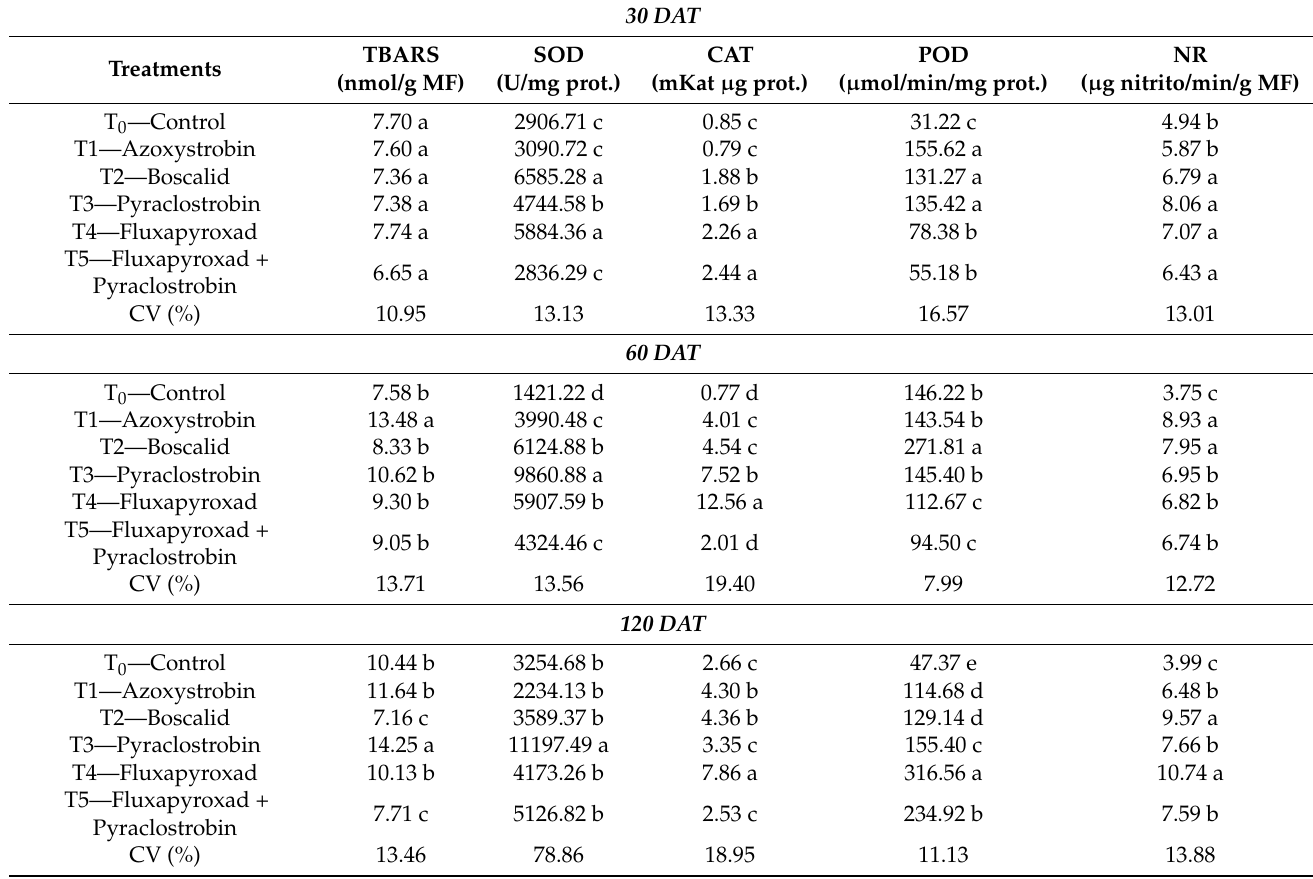
Table 3. Lipid peroxidation (TBARS), superoxide dismustase (SOD), catalase (CAT), peroxidase (POD) and nitrate reductase (NR) activity of tomato plants treated with fungicides with physiological effect, at different collection